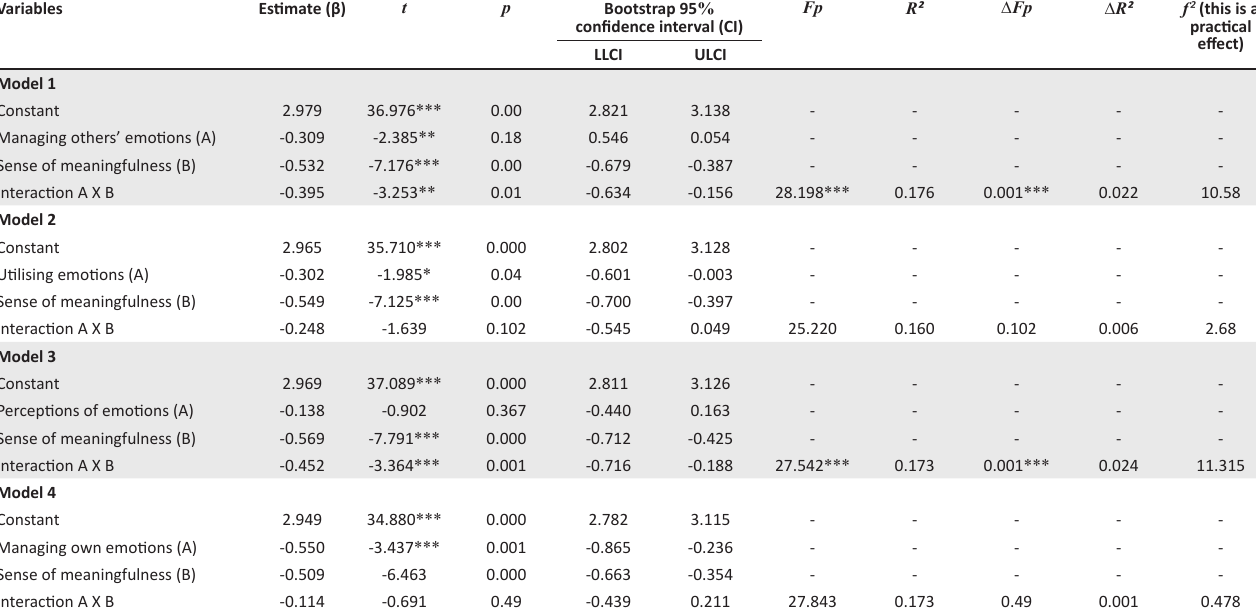
TABLE 2: Moderated regression results: Managing others’ emotions, utilising emotions, perceptions of emotions, managing own emotions moderated by sense of meaningfulness in predicting exhaustion ( N = 409).